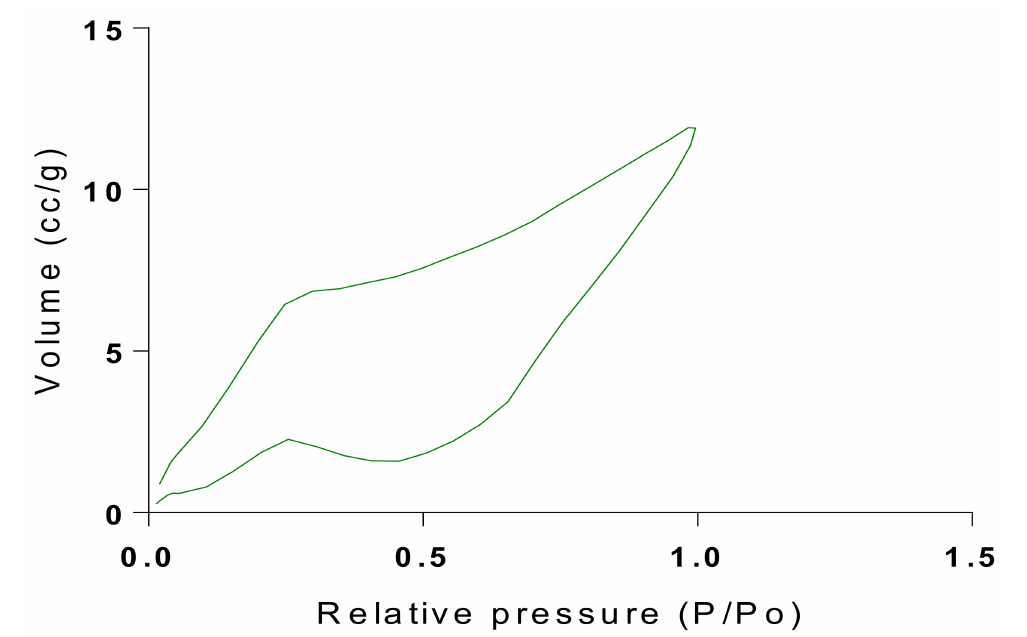
Figure 18. Isotherm of